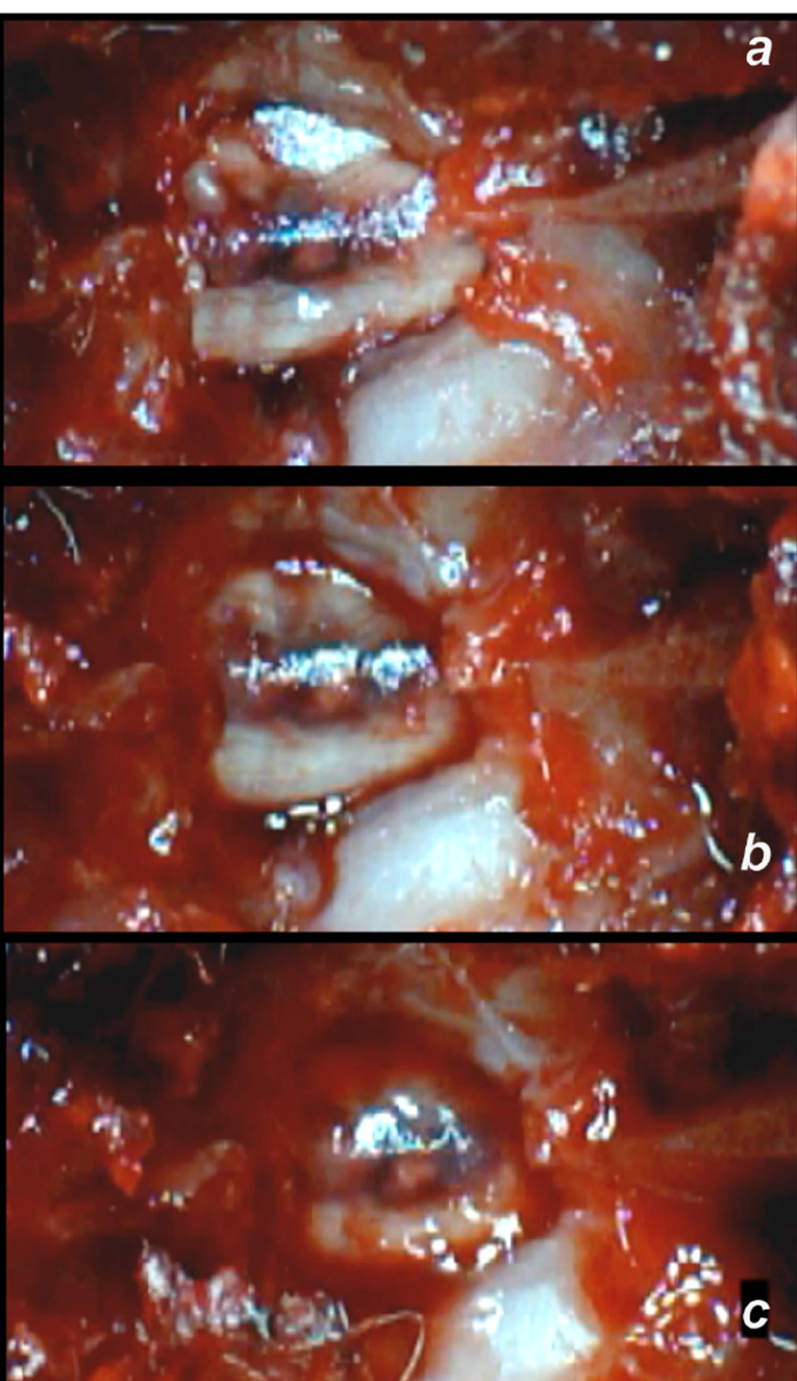
Figure 5. Spinal cord hematoma presentation following spinal cord compression (for 1 min) (a camera attached to a VMS-004 Discovery Deluxe USB microscope (Veho, Denver, CO, USA)). Presentation at 10 min following injury, before therapy saline (5 mL/kg ip) ( a ), and after saline application, at 10 min ( b ) and at 20 min ( c ). BPC 157. Contrarily, the otherwise progressing course of the spinal cord swelling and hematoma (Figure 6a) was reversed by the intraperitoneal application of BPC 157 at 10 min post-injury, and the recovery occurred in minute intervals (Figure